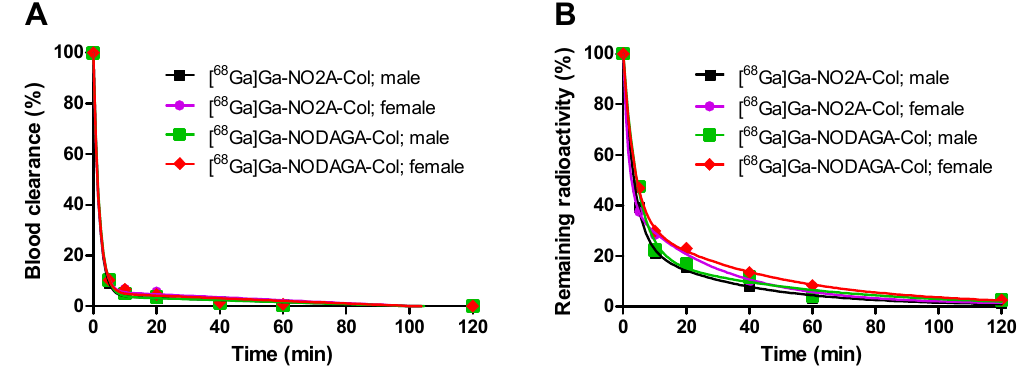
Figure 3. ( A ) Blood clearance of [ 68 Ga]Ga-NO2A-Col and [ 68 Ga]Ga-NODAGA-Col administered intravenously (R 2 = 0.9988 ( ■ ), 0.9994 ( ● ), R 2 = 0.9989 ( ■ ) and R 2 = 0.9994 ( ♦ )) with the respective half-life values of 1.19, 1.21, 1.23 and 1.29 min. ( B ) Elimination kinetics of [ 68 Ga]Ga-NO2A-Col and [ 68 Ga]Ga-NODAGA-Col administered intravenously with the respective half-life values for the fast/slow phases of 19.77/1.15 min (R 2 = 0.9994 ( ■ )), 22.89/2.29 min (R 2 = 0.9992 ( ● )), 29.33/2.41 (R 2 = 0.9995 ( ■ )) and 36.55/3.14 (R 2 = 0.9958 ( ♦ )).